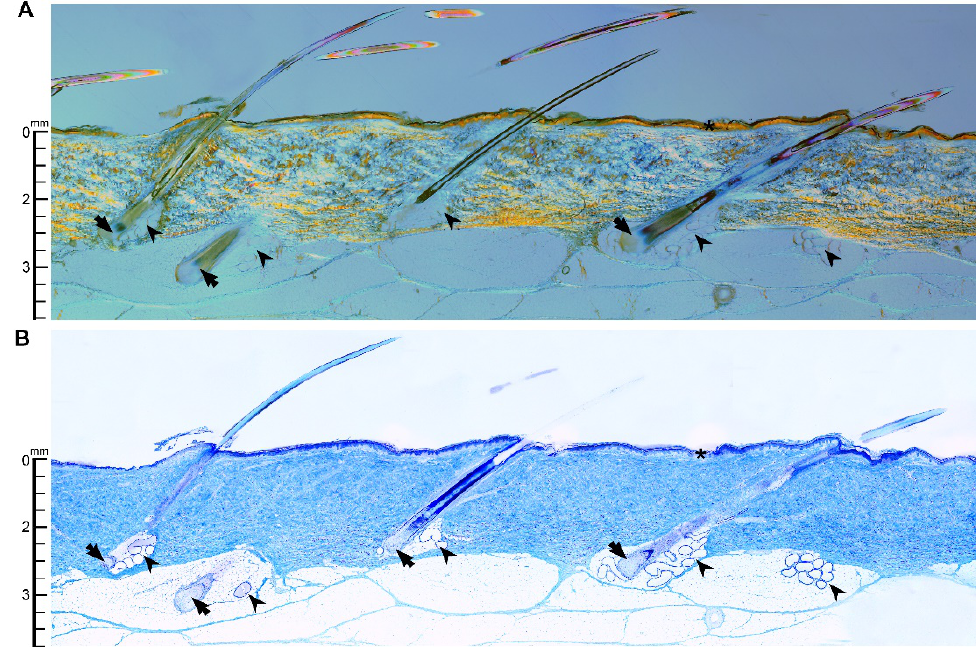
Figure 7. Representative longitudinal section (~75 µm thick) of PMMA-embedded skin using po- larized light ( A ) and transmission light ( B ) microscopy with Sanderson’s rapid bone stain. Notable features are shown: the thin stratum corneum (asterisk), the deepest part of the hair follicles (arrow), and the sebaceous glands (arrowhead). The scale bars along the left are oriented to illustrate the approximate depth (in mm) of tissue features from the stratum corneum. Table 1. Approximate diffusion coefficients and corresponding diffusion times are listed as a comparative reference .